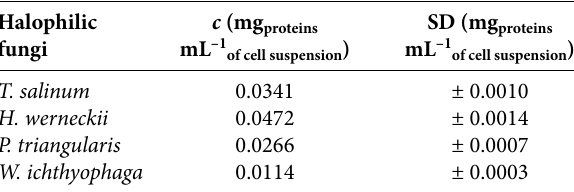
Table 1 : Initial concentration of proteins in halophilic fungi cell sus- pensions before homogenization and standard deviation of meas- urements (SD).